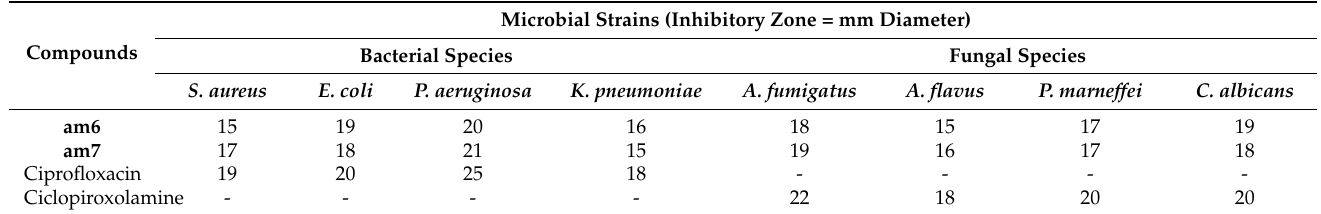
them for their in vitro antibacterial potential by the serial tube dilution method using streptomycin as a reference drug. The results of the antimicrobial evaluation studies